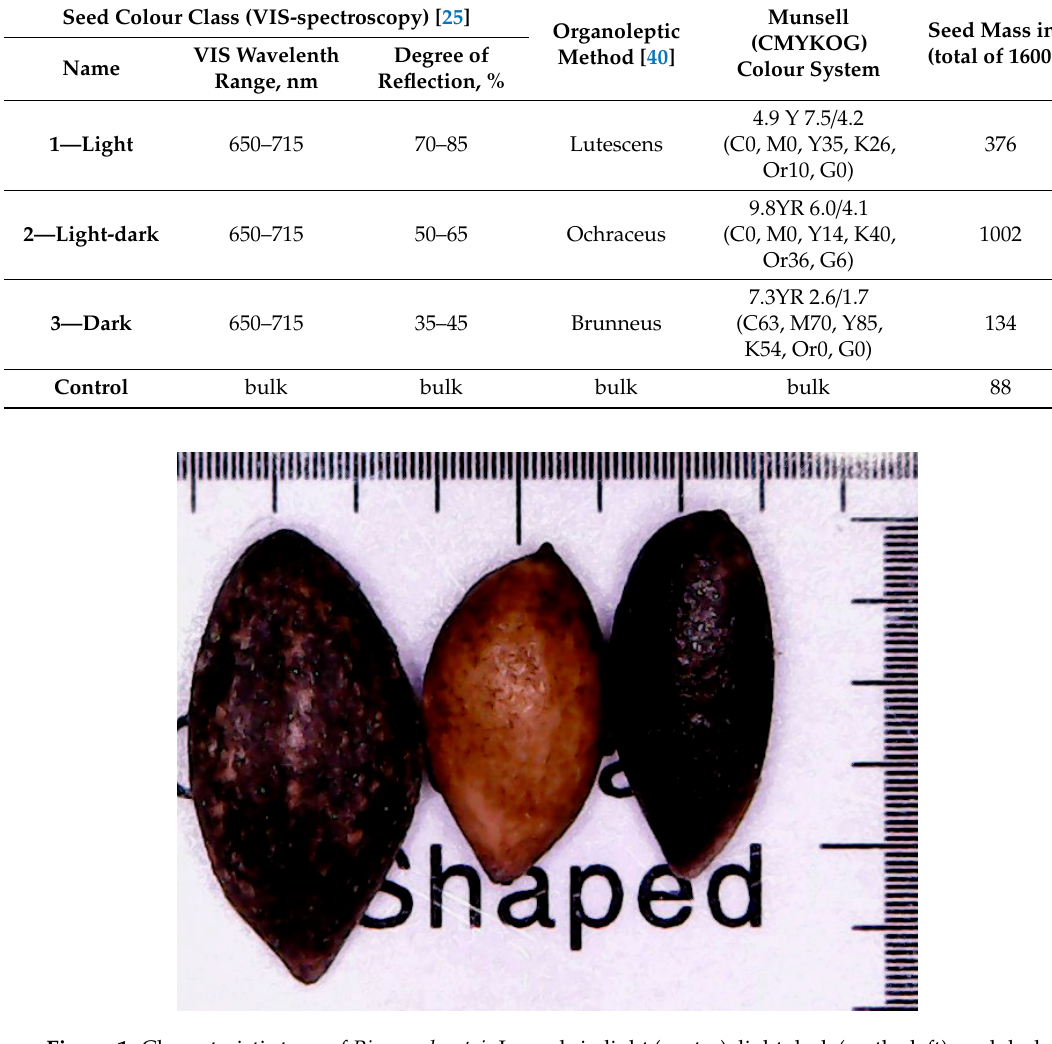
Table 2. Meteorological data for the growing season 2018 in Voronezh Region (51.650, 39.250) adapted in http://pogoda-service.ru/climate_table.php. Month Average Temperature, °C (Mean±SE)